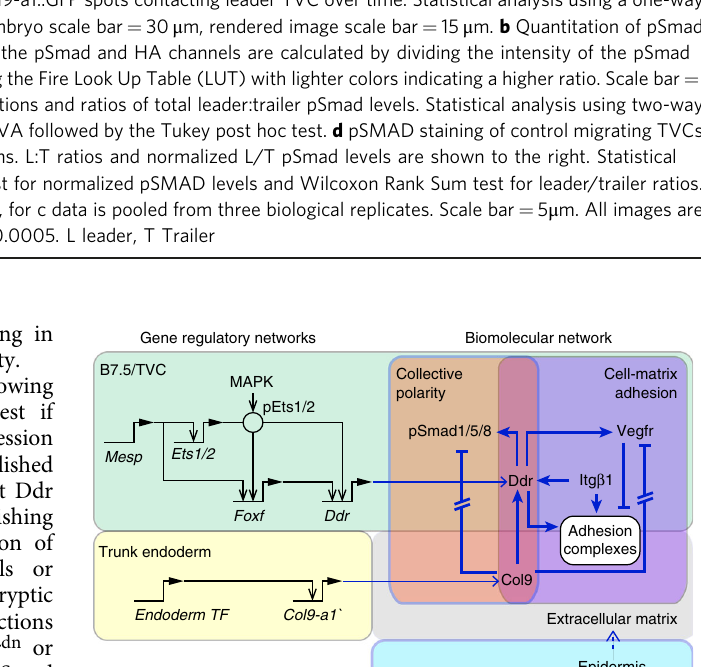
21. Arrows point to ventral accumulation of Col9-a1::GFP. Calculation of total exposure of leader or trailer to endodermal collagen at each embryonic stage.